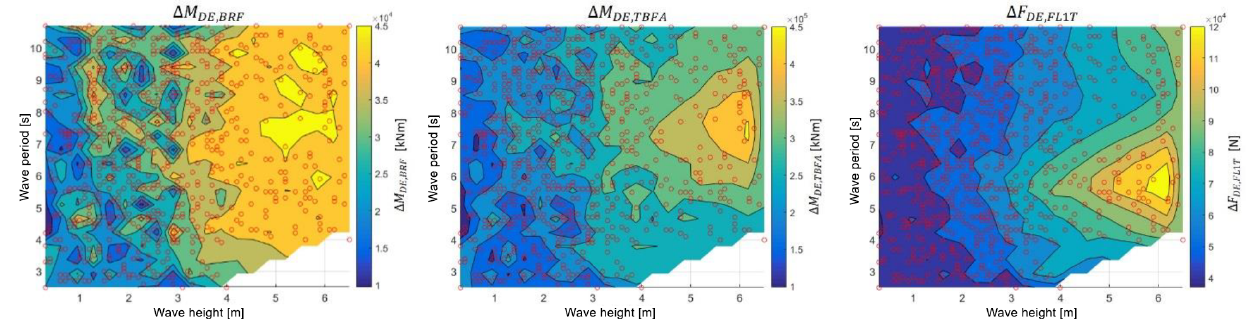
Figure 12. DEL contour plots for blade root flap-wise bending moment, tower base fore–aft bending moment and fairlead 1 tension. Plotted for all load ranges and showing channel-specific excitation periods. Red dots indicate performed simulations. Results are obtained independent of wind speed.